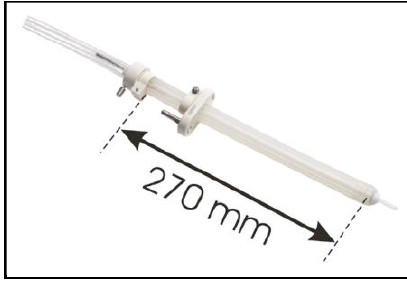
Figure 3. Dose distribution for pre-operative endorectal brachytherapy treatment obtained using the PLATO treatment planning system: axial (top left), coronal (top right), and 3D (bottom left) view of the dose distribution. Dose – volume histograms (bottom right) of the target volume and sur- rounding critical structures.